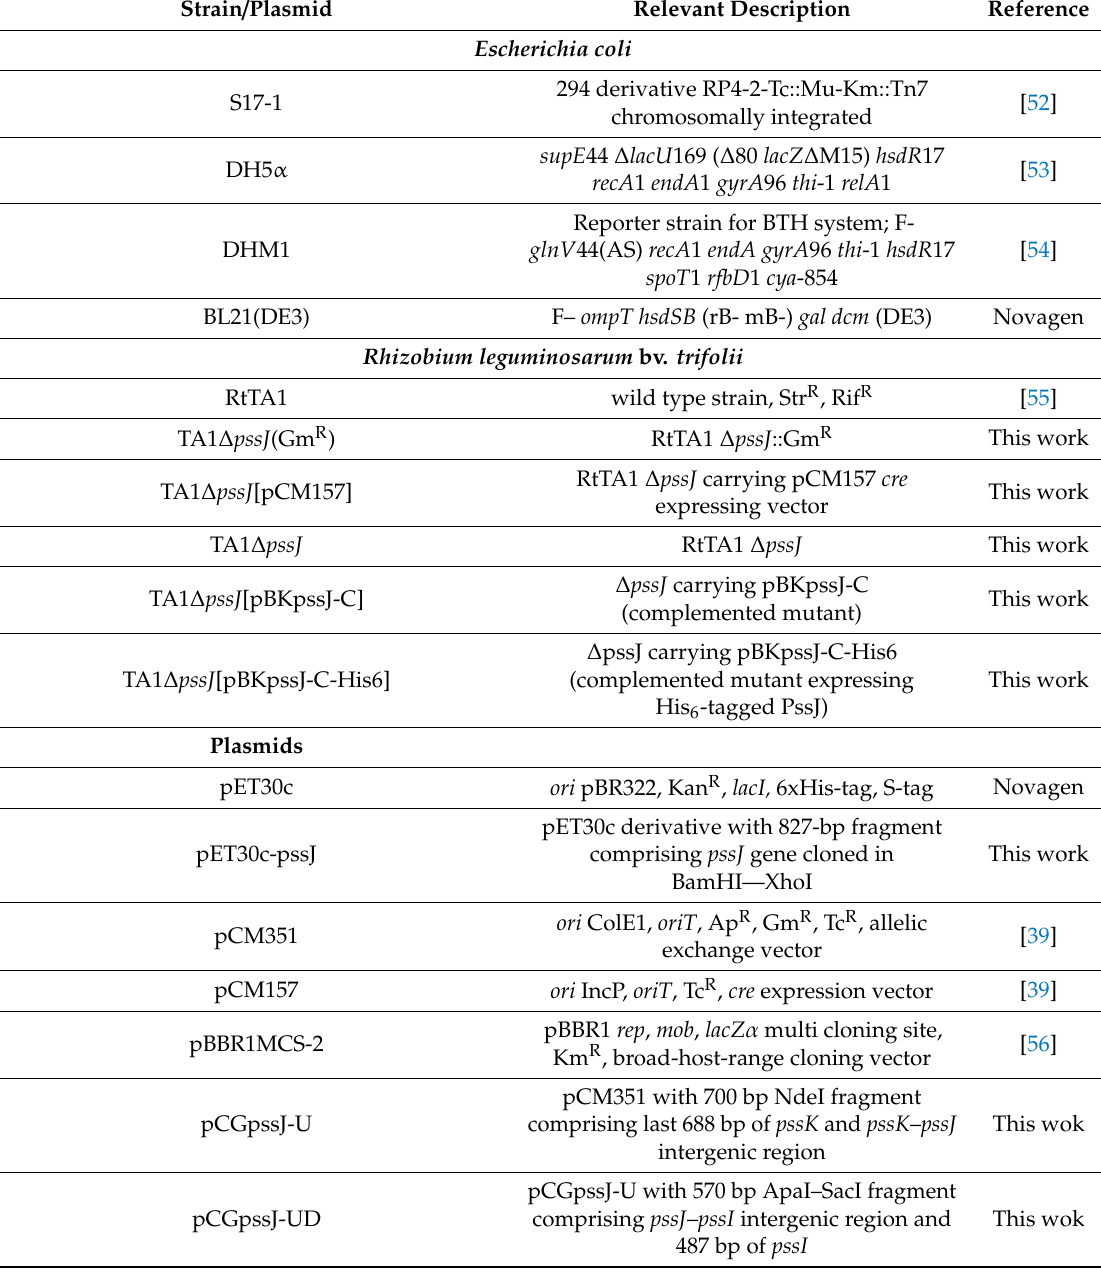
Table 1. Strains and plasmids used in this